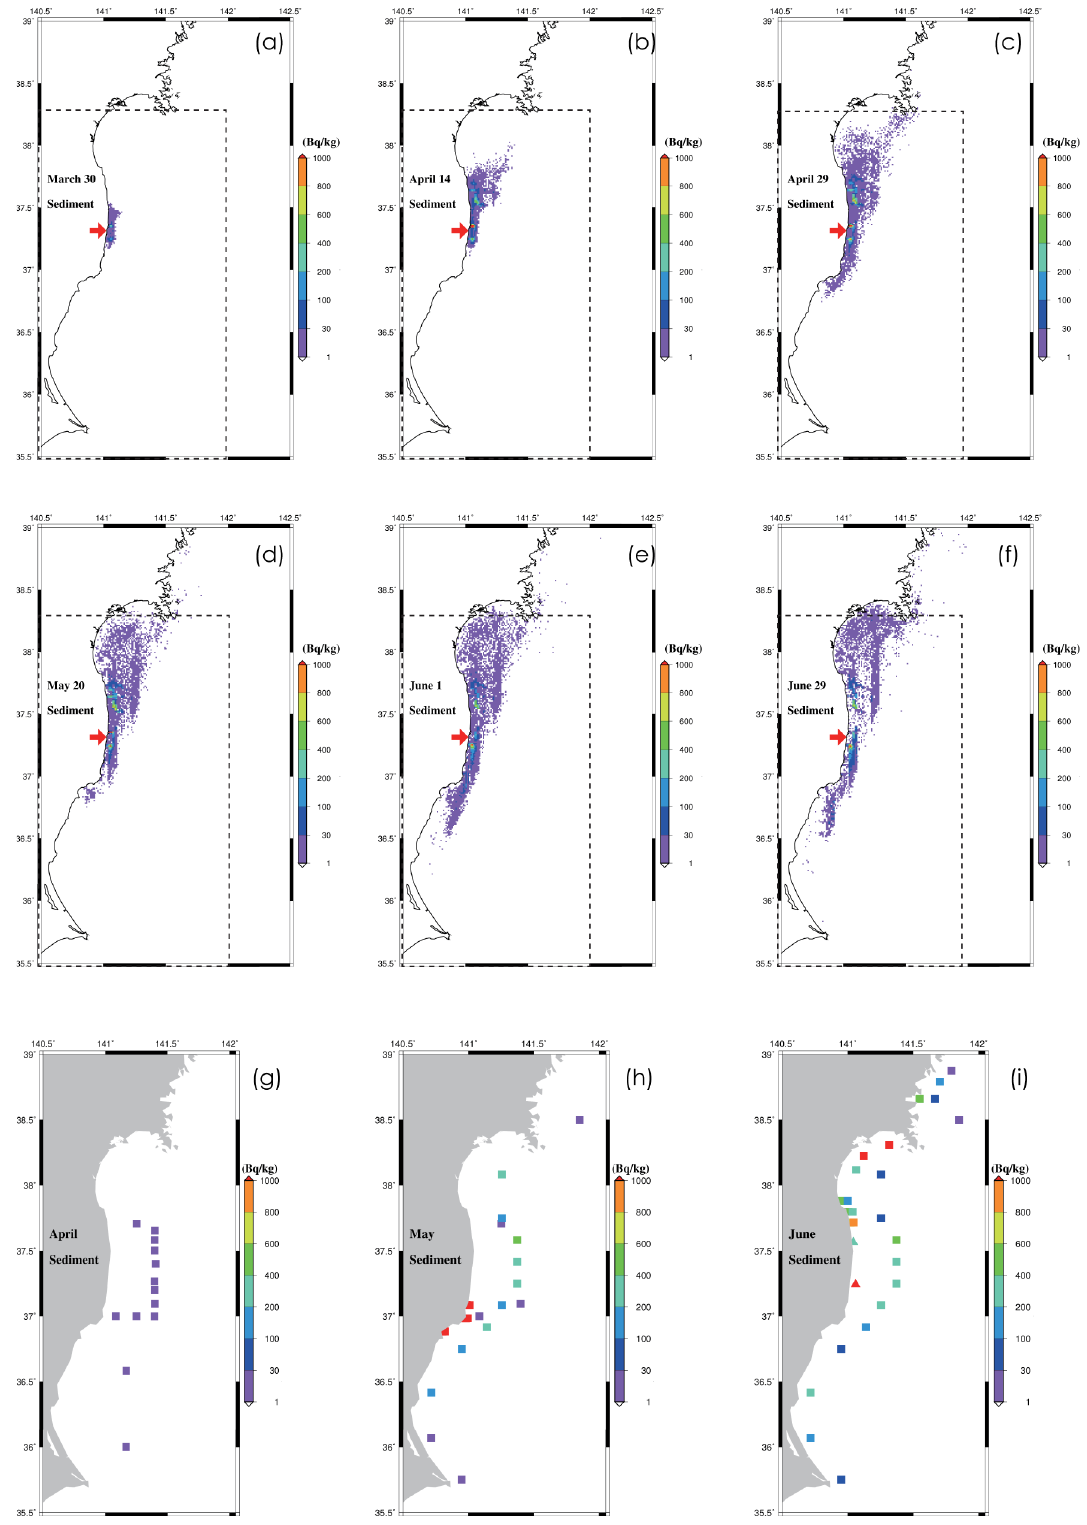
Fig. 7. (a–f) Radionuclide concentration in bottom sediment phase in CTRL [Bqkg − 1 dry]: (a) 30 March, (b) 14 April, (c) 29 April, (d) 20 May, (e) 1 June, and (f) 29 June 2011. (g–i) Monthly averages of observed radionuclide concentration in bottom sediments: (g) April, (h) May and (i) June 2011. Note that data from TEPCO are measured in [Bqkg − 1 wet] and are shown in triangles. The values are also converted to [Bqkg − 1 dry] by multiplying the value by 0.75 (MEXT,